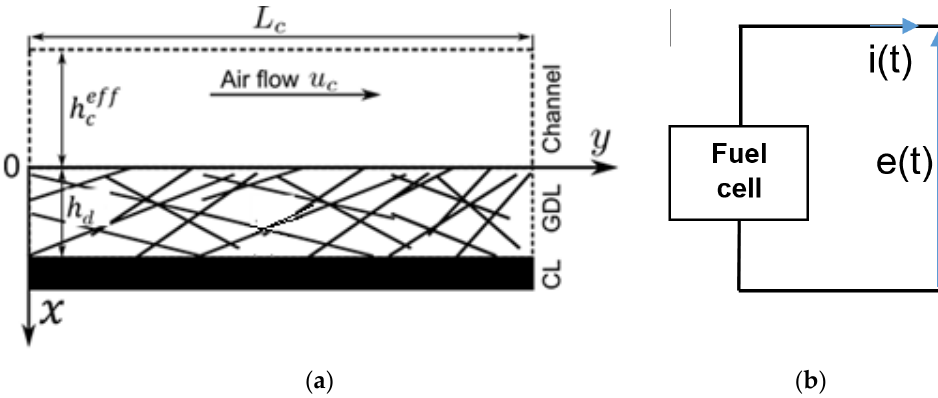
Figure 1. ( a ) PEMFC half-cell geometry reprinted from [28]. ( b ) A simple fuel cell electrical circuit.